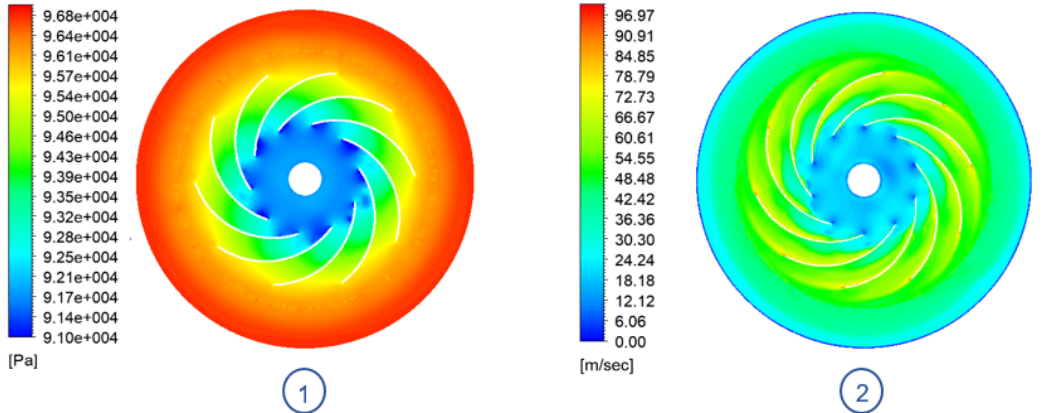
Figure 12. TBP model impeller plane view @ 18,500 RPM: ( 1 ) Absolute pressure contour. ( 2 ) Velocity